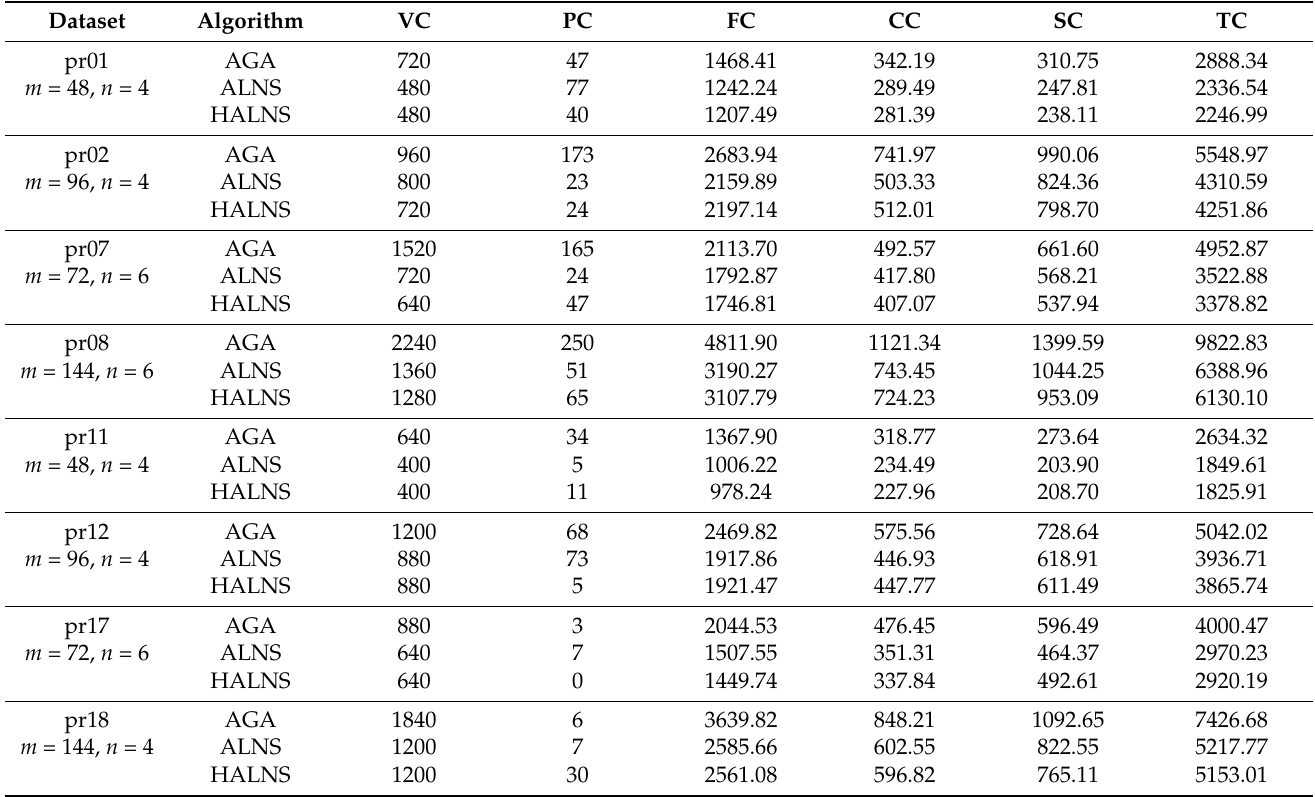
Table 6. Comparison results of different